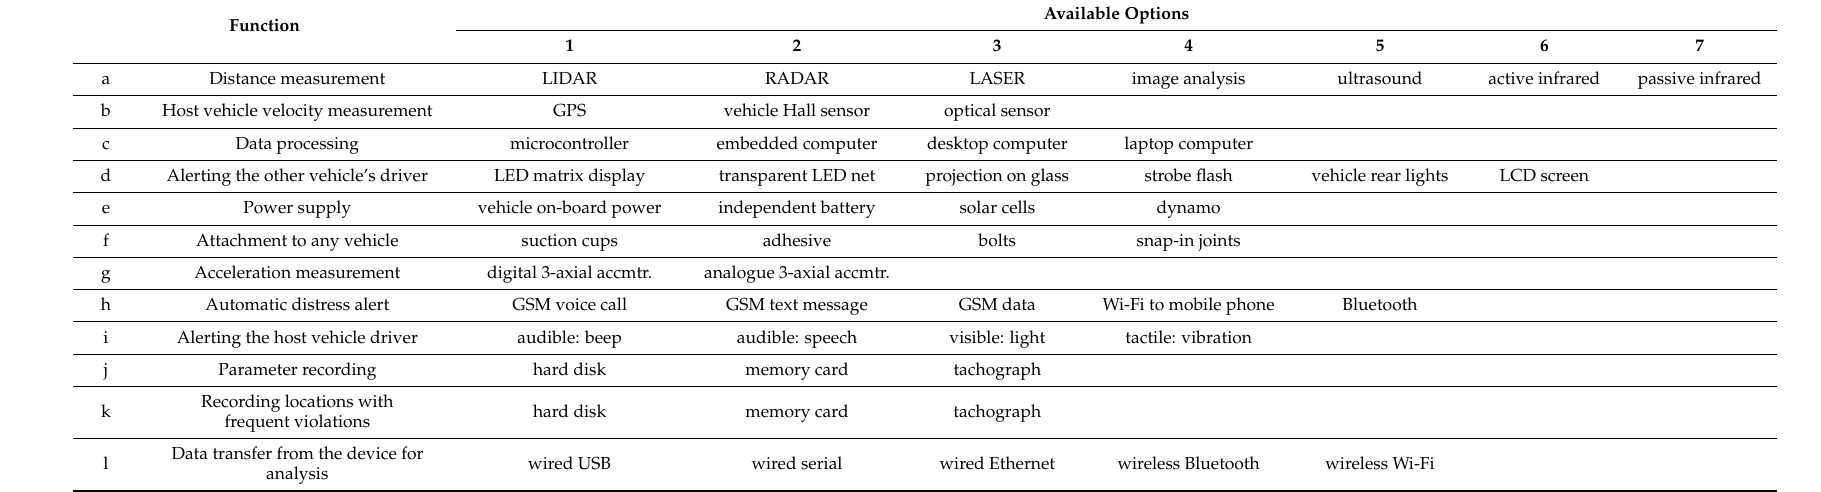
Table 1. The morphological